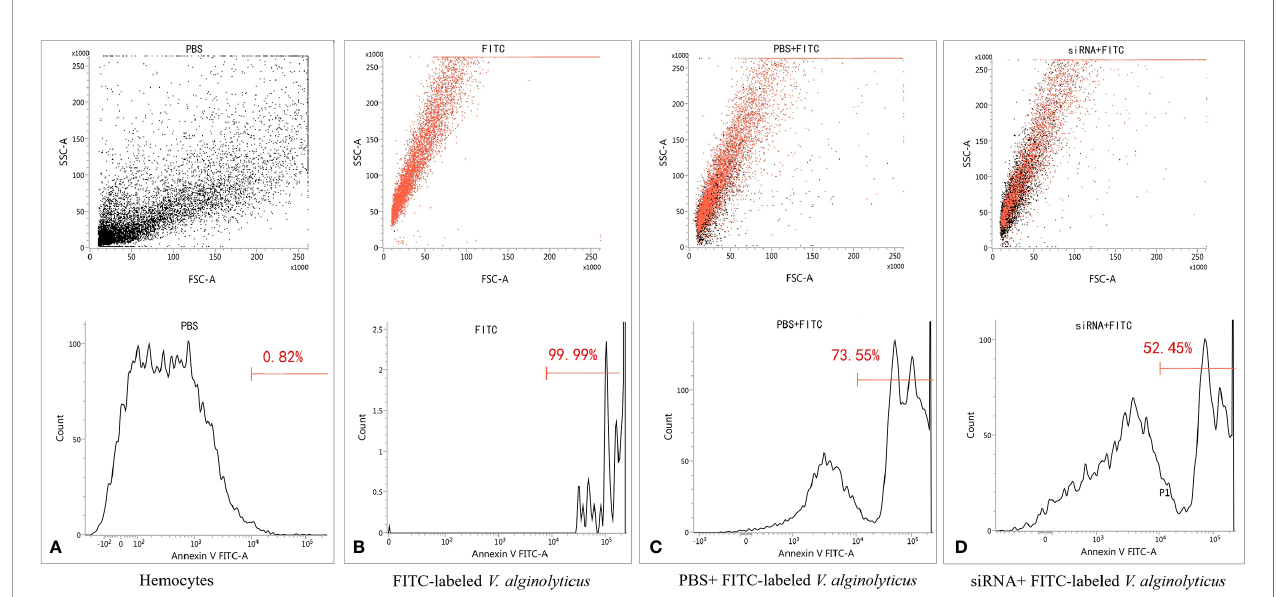
FIGURE 7 | Flow cytometry assay of phagocytosis. (A) Hemocytes. (B) FITC-labeled V. alginolyticus . (C) PBS+ FITC-labeled V. alginolyticus (D) siRNA+ FITC- labeled V. alginolyticus.